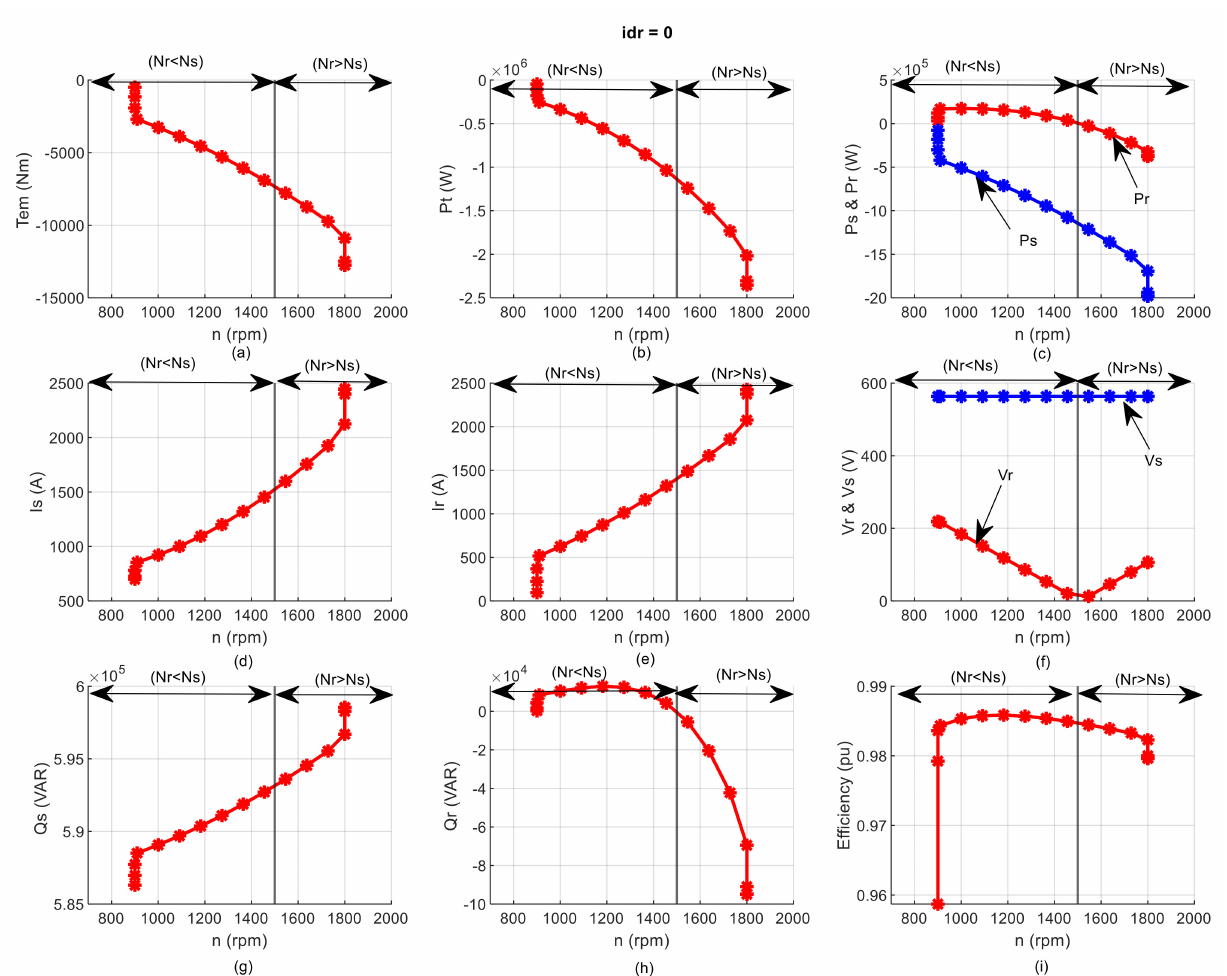
Figure 4. SS Characteristics of 2 MW DFIG Idr = 0; ( a ) Torque, ( b ) Total Power, ( c ) Stator and Rotor Power, ( d ) Stator Current, ( e )Rotor Current, ( f ) Stator and Rotor Voltage, ( g ) Stator Reactive Power, ( h ) Rotor Reactive Power, ( i )